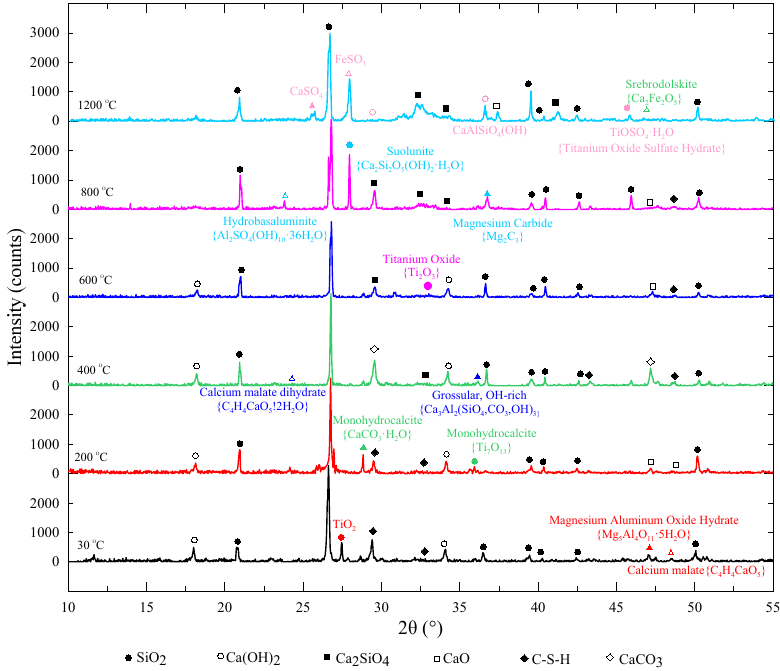
Figure 14. XRD results of PVA-ECC after exposure to various temperatures.